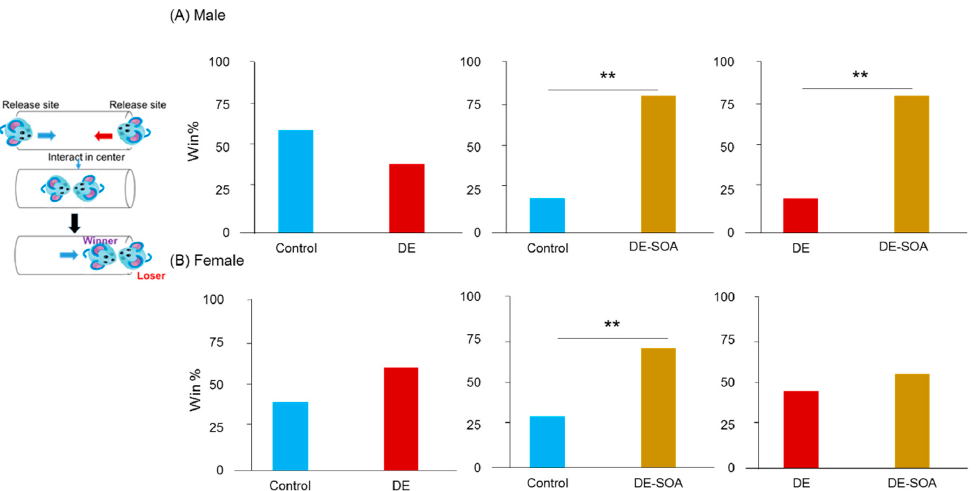
Figure 2. Assessment of social dominance behavior using tube test. Social dominance behavior in ( A ) male and ( B ) female rats of the control and the DE- and DE-SOA-exposed rats ( n = 16, ** p < 0.01 vs. corresponding control or DE-exposed rats).